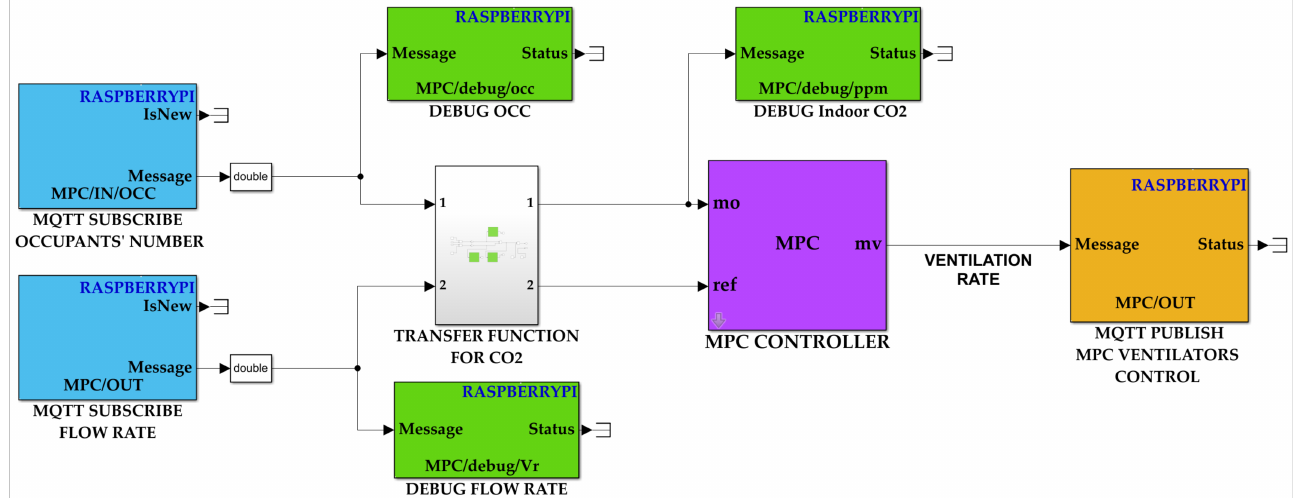
Figure 9. MATLAB/Simulink model for ventilation system’s control using